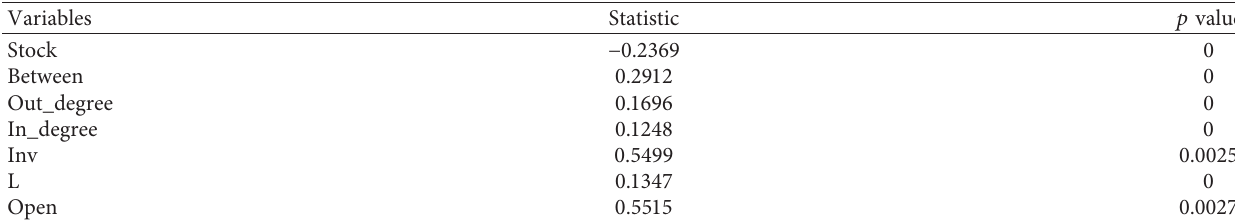
Table 4: Harris-Tzavalis unit-root test.